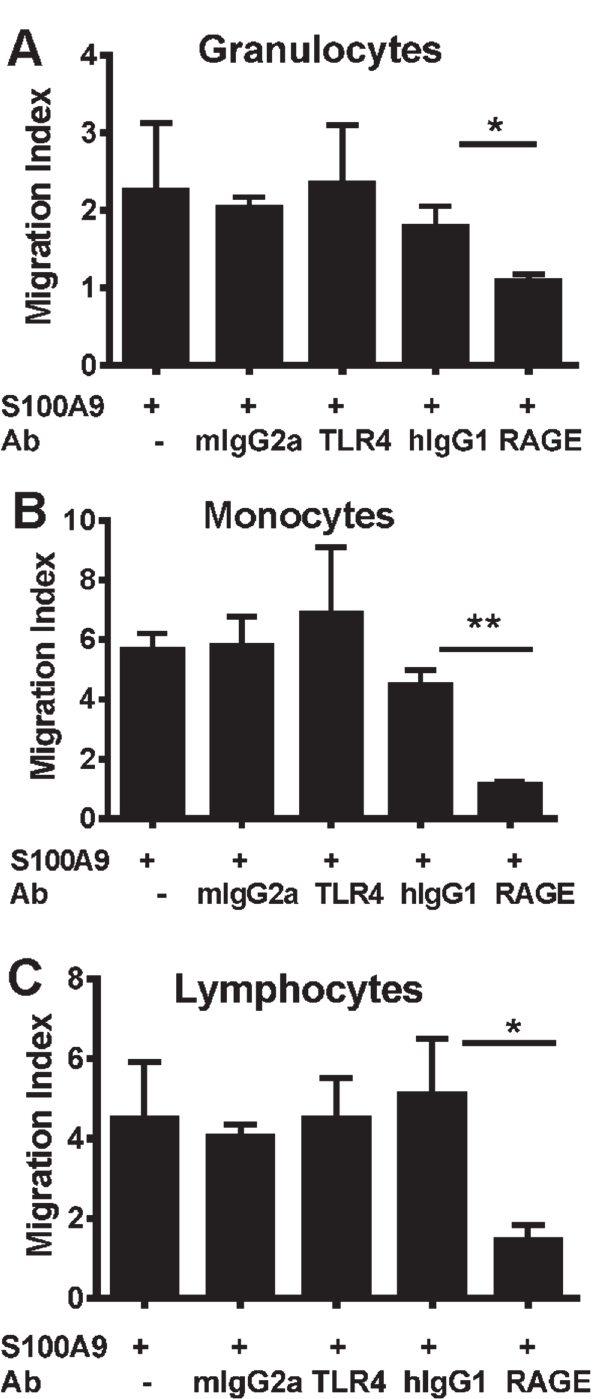
Fig 3. Human S100A9 induced migration of leukocyte populations is inhibited by anti-RAGE Ab but not anti-TLR4 Ab. Chemotactic responses to S100A9 of human leukocyte populations were examined at the optimal concentration (1 ng/ml). The effects of TLR4 and RAGE blockade on S100A9-mediated migration of granulocytes (A), monocytes (B), and lymphocytes (C), with 10 μ g/ml of anti-RAGE, anti-hTLR4 Ab and isotype control Abs. Data shown is mean ± SD of triplicate samples from a representative of three independent experiments. Unpaired T-test was used to determine if the anti-RAGE or anti-TLR4 treatments were significantly different from the isotype control Ab ( * P < 0.05, ** P < 0.01, *** P <